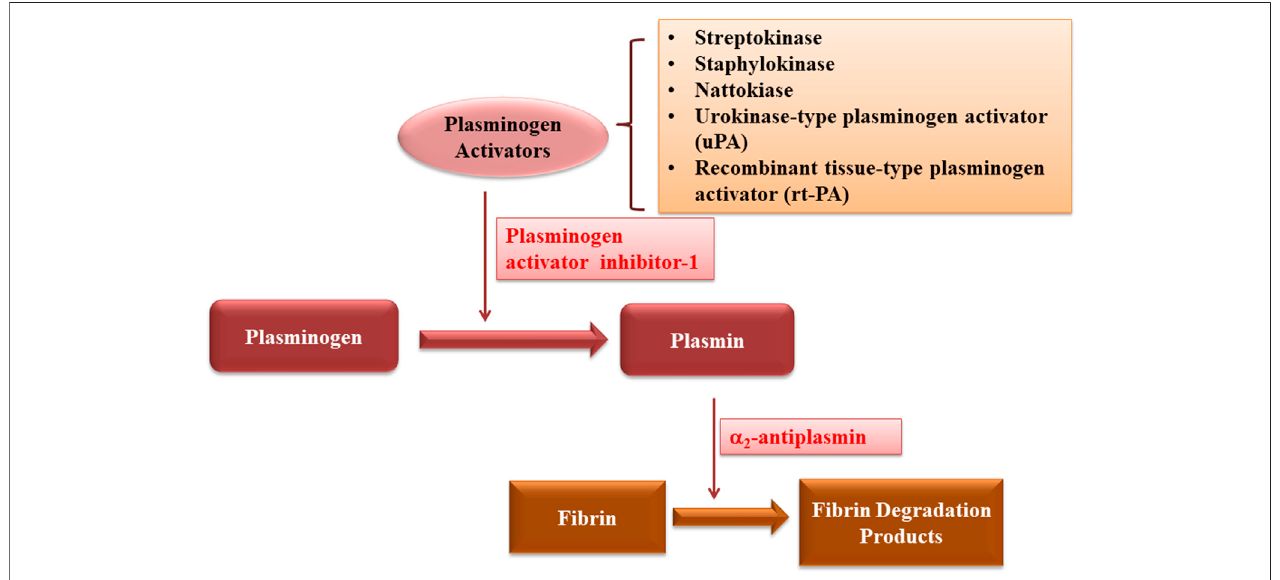
FIGURE 6 | Schematic diagram showing the mechanism of action of thrombolytic drugs.